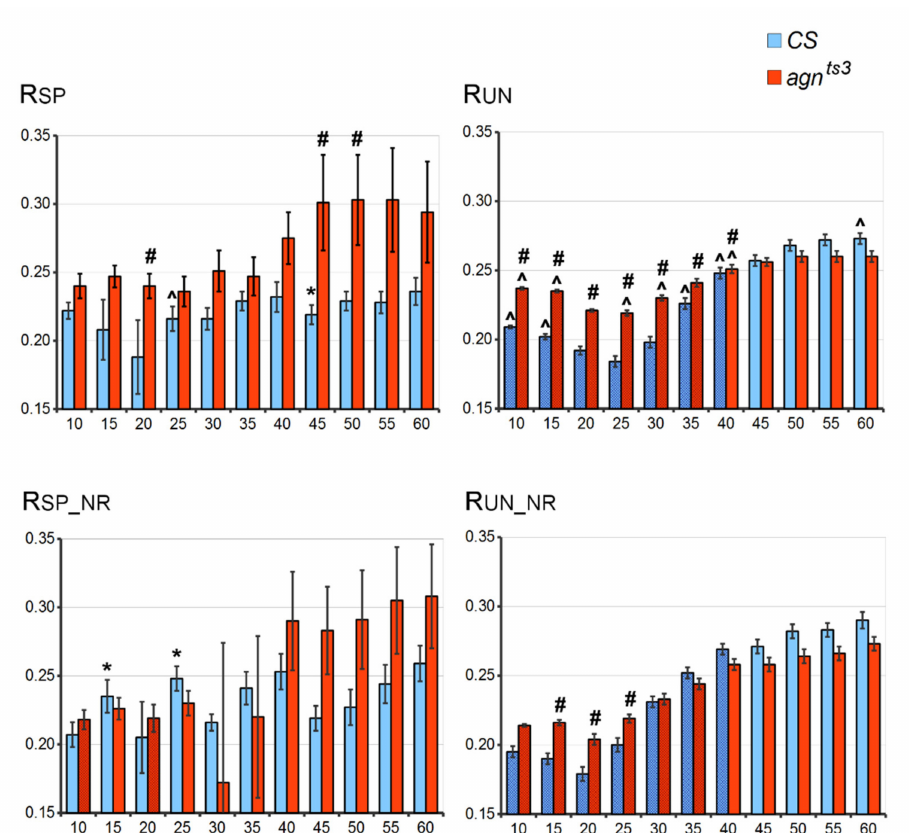
Figure 1. R values at different fragment lengths. X axis: L (nt). Y axis: R (conventional units). Difference: # from CS , ˆ from the case with excluded repeats, * from the case with unspecific correlation, shading – difference from R calculated at L50 (two-sided Mann–Whitney U-test; p < 0.05). Standard error of mean is shown. Here and below: SP—specific, SP_NR—specific with repeats exclusion, UN—unspecific, UN_NR—unspecific with repeats exclusion. Sampling number: for specific correlations, n = 6–20 ( CS ), 5–28 ( agn ts3 ); for unspecific correlations, n = 568–2235 ( CS ), 667–2987 ( agn ts3 ). Total number of R estimations: for specific correlations, n = 90 ( CS ), 95 ( agn ts3 ); for unspecific correlations, n = 10,620 ( CS ), 11,210 ( agn ts3